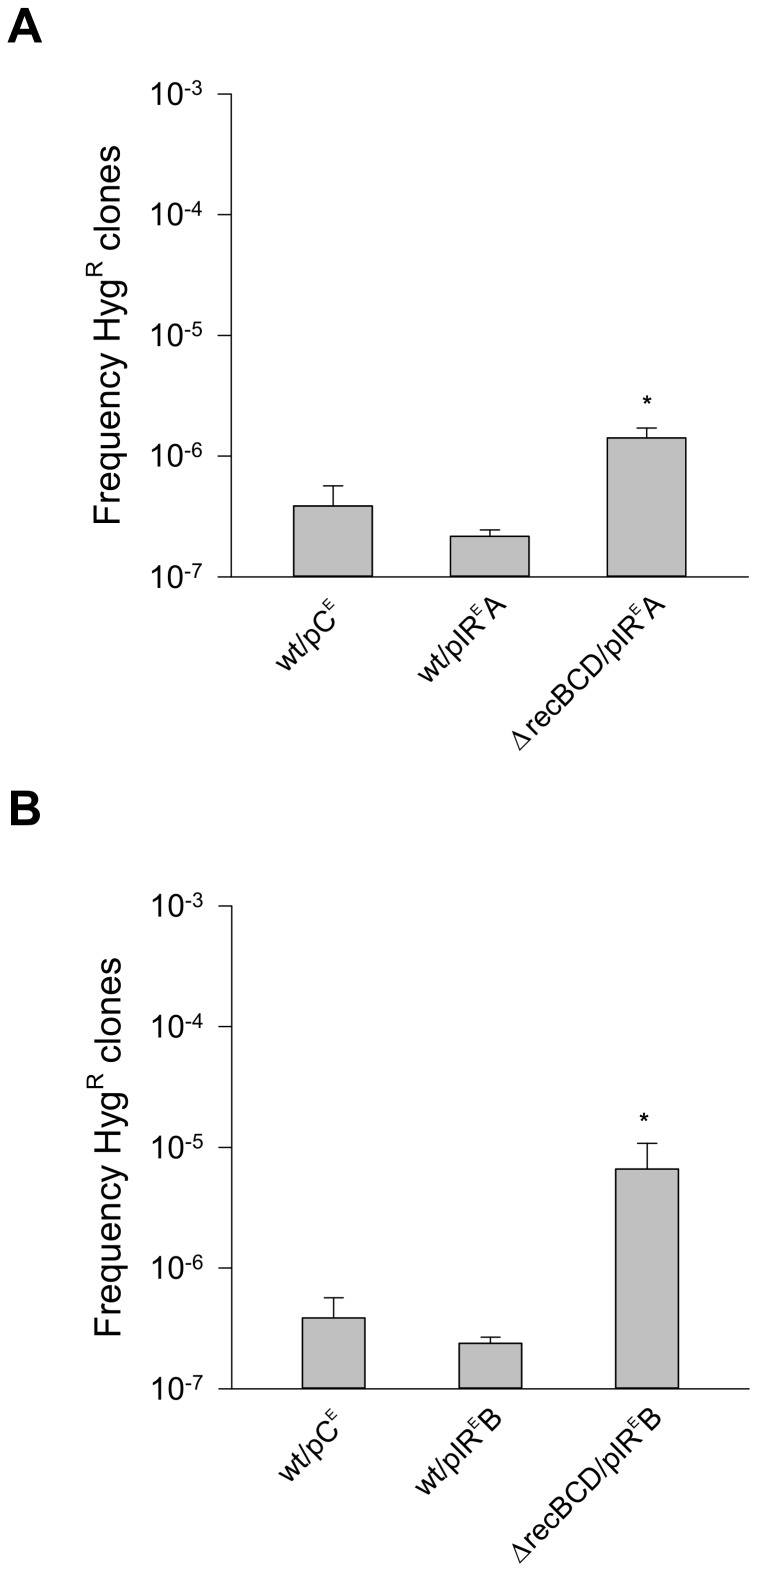
Precise deletions and SSA.RecBCD deficiency increases the frequency of precise deletions between IRs. Panels A and B, x-axis, M. smegmatis strains; y-axis, frequencies of HygR CFUs; asterisks, p<0.05 (pair-wise Holm-Sidak test for ΔrecBCD M. smegmatis against wild-type). Panel A, wt/pCE, wild-type/pMV206KmHyg::Gm (control); wt/pIREA, wild-type/pMV206KmHyg::OligoIRGmA
lacZ; ΔrecBCD/pIREA, ΔrecBCD/pMV206KmHyg::OligoIRGmA
lacZ. Panel B, wt/pCE, as in Panel A; wt/pIREB, wild-type/pMV206KmHyg::OligoIRGmB; ΔrecBCD/pIREB, ΔrecBCD/pMV206KmHyg::OligoIRGmB.